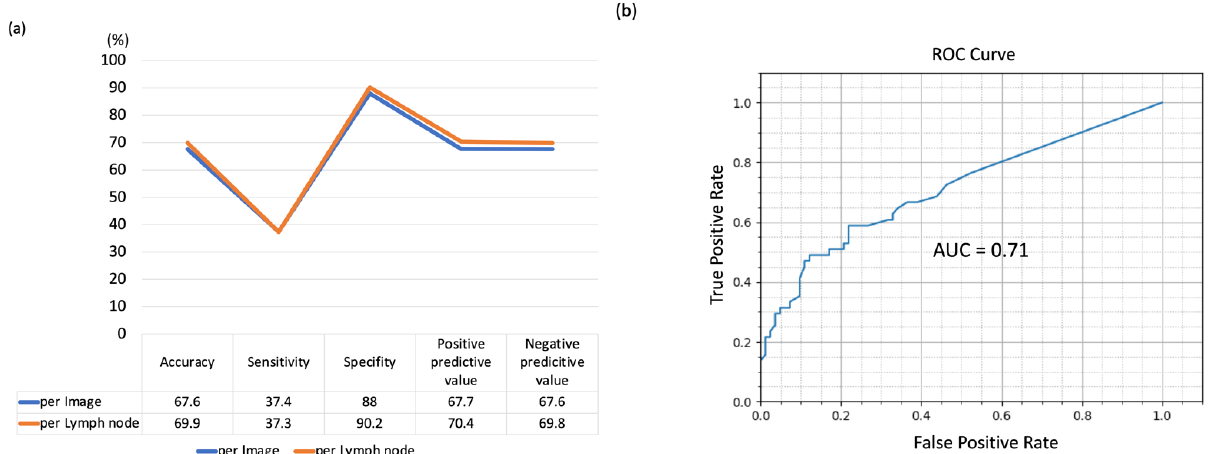
Figure 3. The result of AI-CAD lung cancer lymph node diagnosis accuracy analysis using echo images by five-fold cross validation method. ( a ) Diagnostic yield by per image basis and per lymph node basis. ( b ) ROC curve.